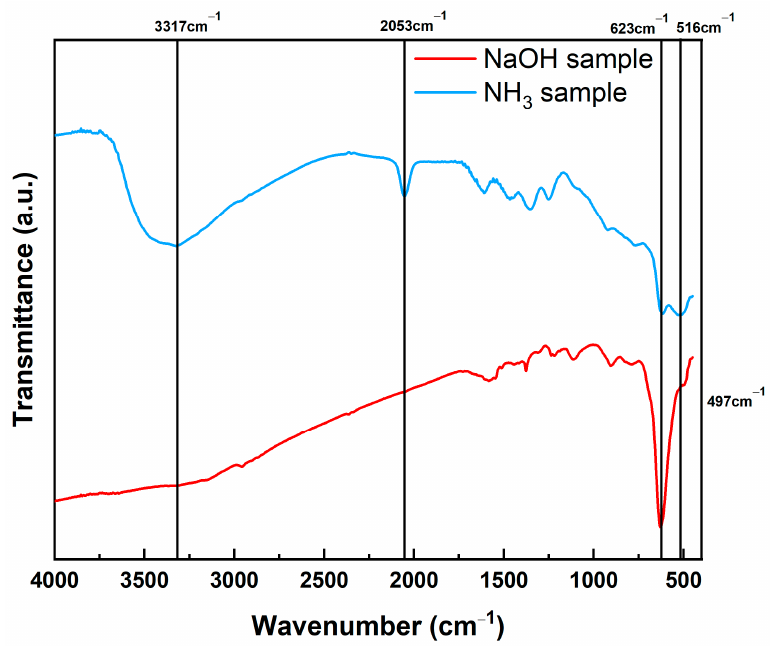
Figure 4. FT-IR spectra of the NH 3 and NaOH samples.